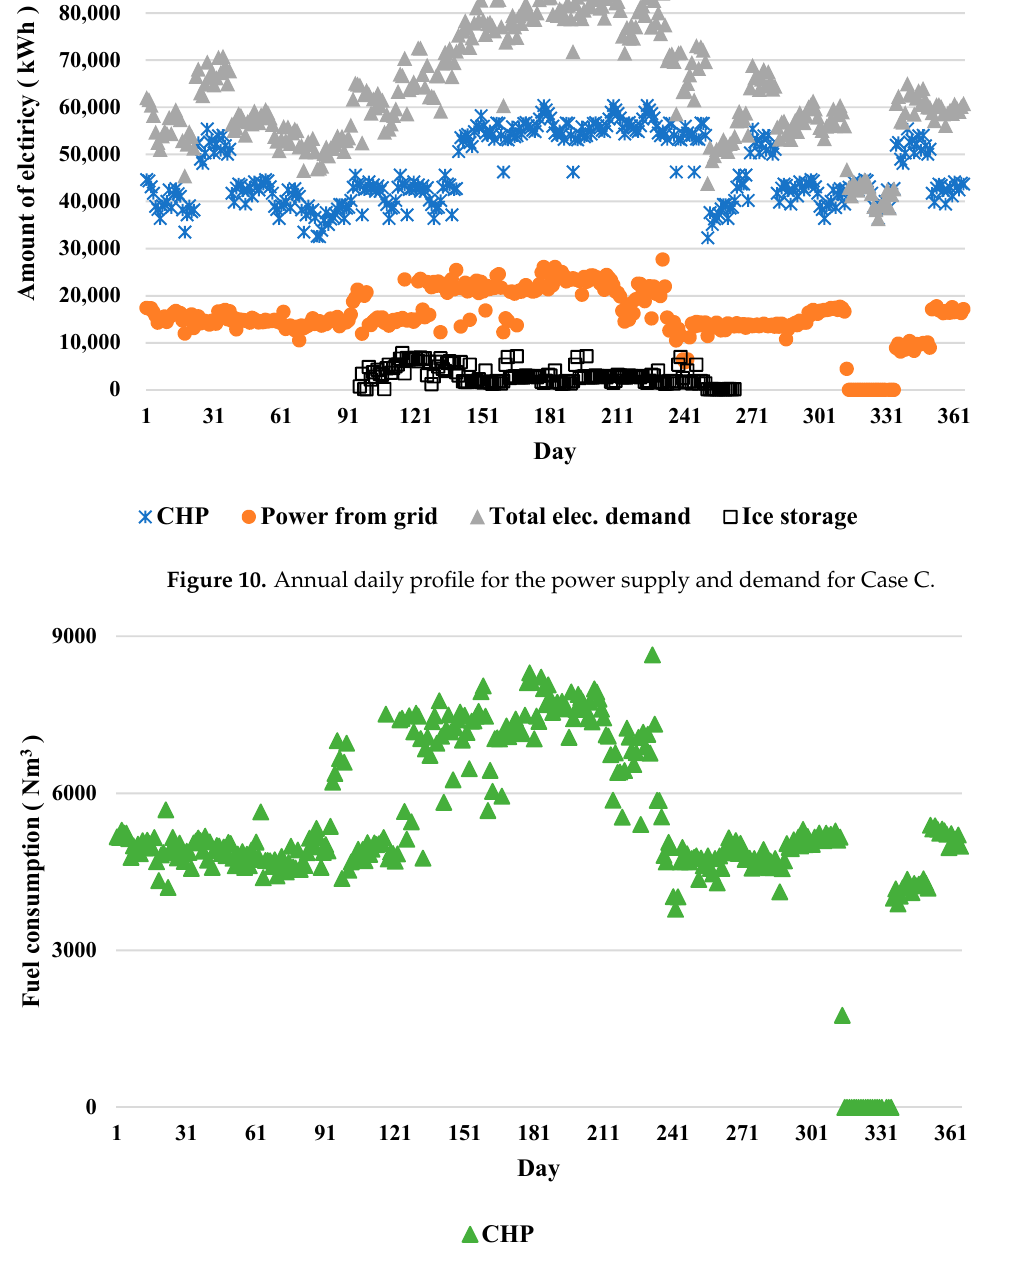
Figure 11. Annual daily fuel consumption profile for CHP for Case C.